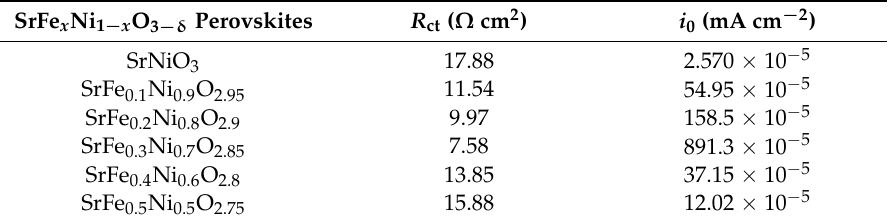
Table S1: UV Absorbances of various TN concentrations for standard work curve.